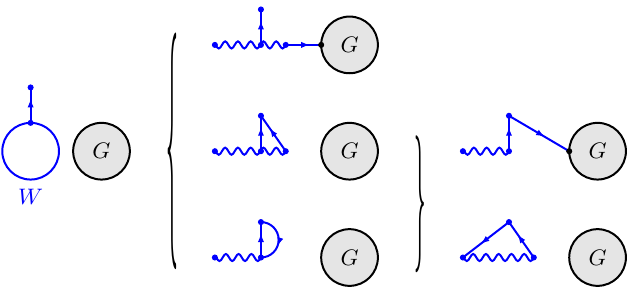
, where G denotes other parts of the graph disconnected z pq